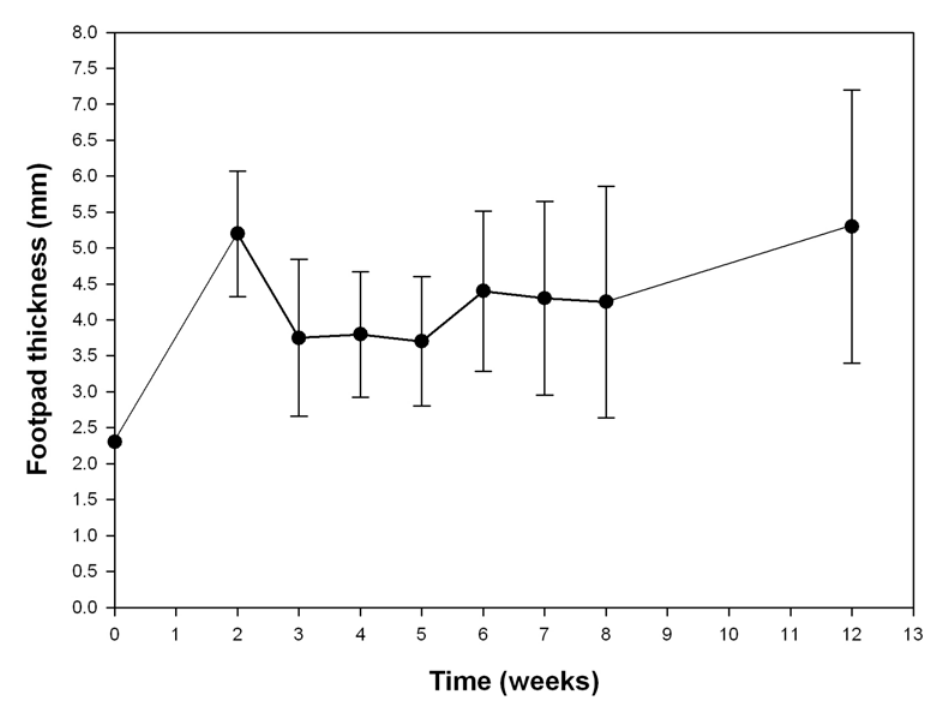
Figure 2. Foot pad thicknes (mm) of the right foot pad of BALB/c mice infected with 20 mg (wet weight) of N. brasiliensis HUJEG-1. Each point represents the mean of 20 animals, the bars correspond to the standard